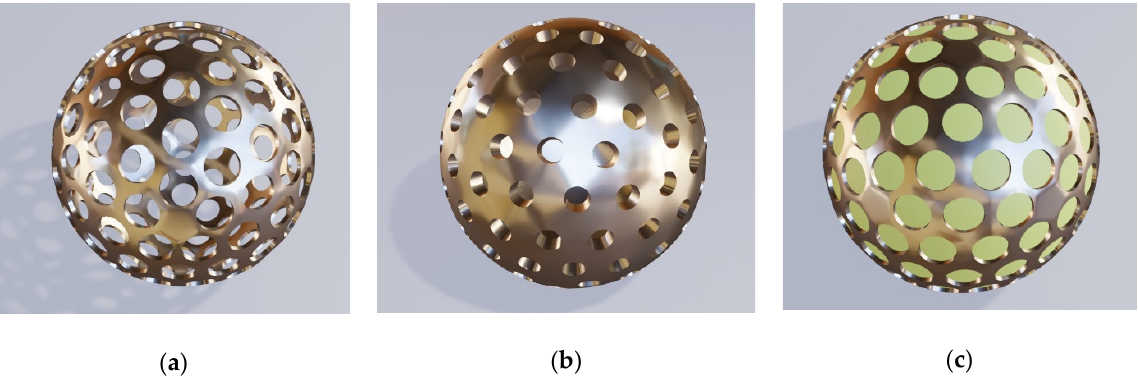
Figure 3. ( a ) Hollow sphere with uniform and regularly patterned holes; ( b ) the same hollow structure, but with a smaller hole diameter and with a thicker metal shell; ( c ) the same structure as in ( a ), but with a core of solid dielectric.